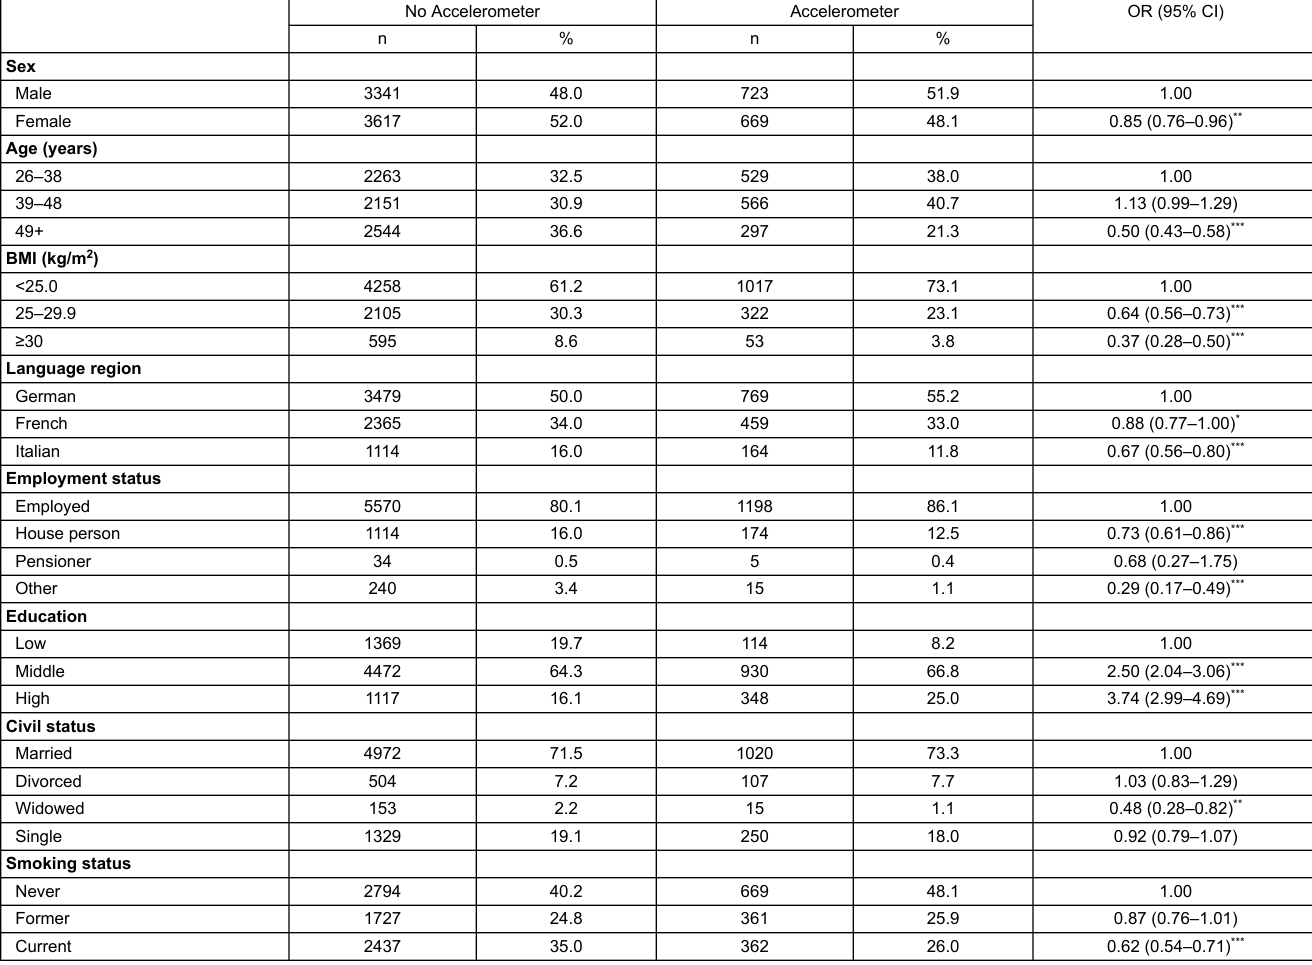
Table S1: Baseline characteristics at SAPALDIA1 of participants who reached the age of 52+ at the time of accelerometry assessments, stratified by participant status in the ac- celerometry